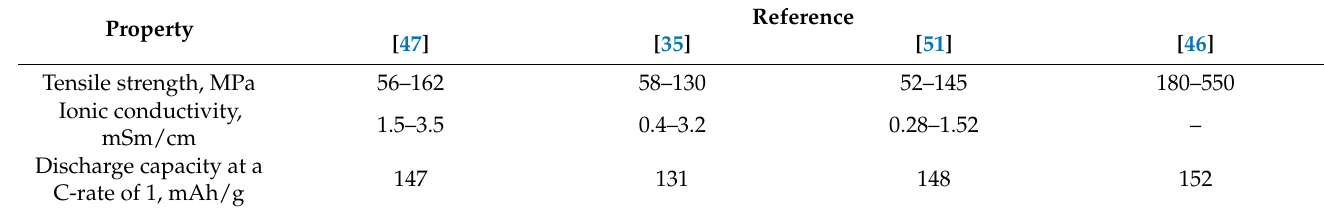
Table 3. Conditions for preparing homogeneous UHMWPE